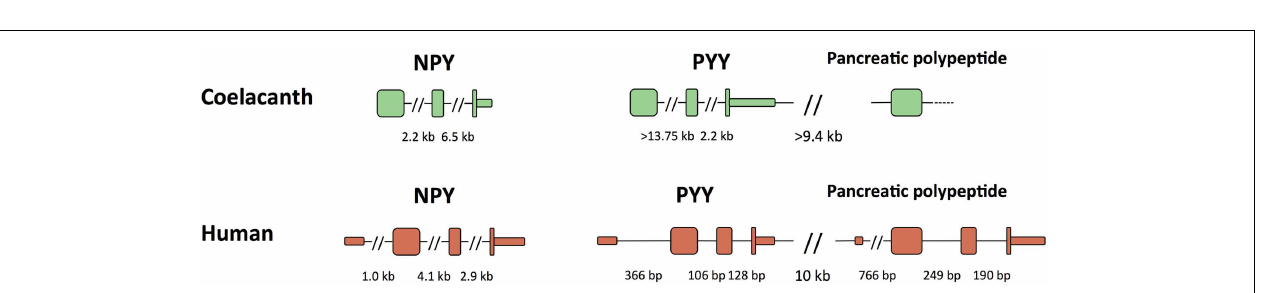
3 (cid:48) -untranslated region is shown until the position of the first consensus poly(A) signal. For the coelacanth genes, the separate 5 (cid:48) -untranslated exons are still unknown as are the two 3 (cid:48) coding exons of the pancreatic polypeptide genes due to incomplete sequence information. Gaps in the genomic sequence of the coelacanth mean that some of its intron sizes and the intergenic distance are minimum